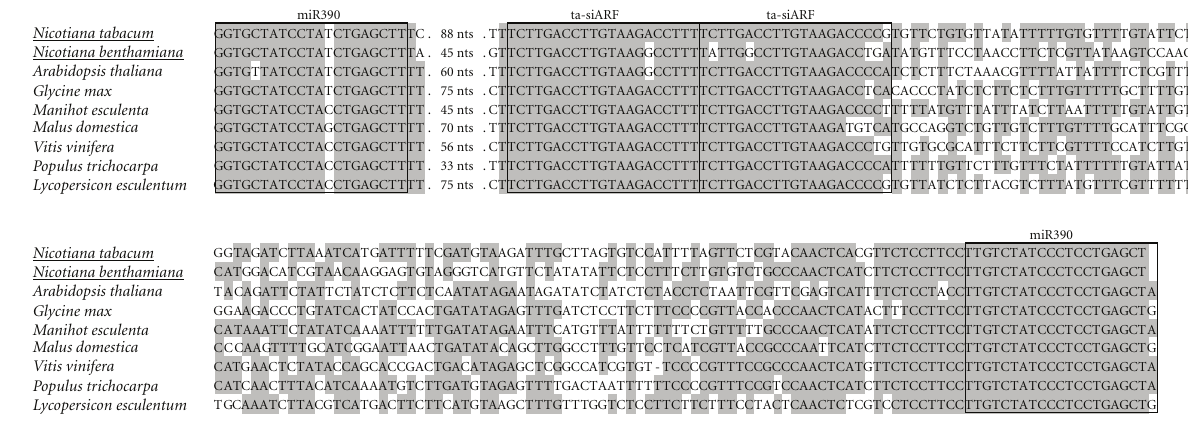
Figure 2: Nucleotide sequence alignment of “280-nt-long” ta-siARF loci of dicot plants. Sequences of Nicotiana tabacum and Nicotiana benthamiana (undelined) were determined in this study, the others were from GeneBank. Boxes indicate miR390 complementary sites and ta-siARF-encoding sequence regions. The length of nonconserved sequence between the 5 (cid:2) -miR390 complementary site and ta-siARF sequence not included in the alignment is indicated. Shading shows residues identical for the given position in most sequences. Sequences of N. tabacum and N. benthamiana miR390 complementary sites originate from primers used for the amplification of ta-siARF loci. GeneBank accession numbers of the sequences included in the alignment are as follows: Nicotiana tabacum , FJ804751; Nicotiana benthamiana , FJ804742; Arabidopsis thaliana , BX838290; Glycine max , BE330988; Manihot esculenta , CK652751; Malus domestica , CN490861; Vitis vinifera , DT025007; Populus trichocarpa , DT498974; Lycopersicon esculentum ,